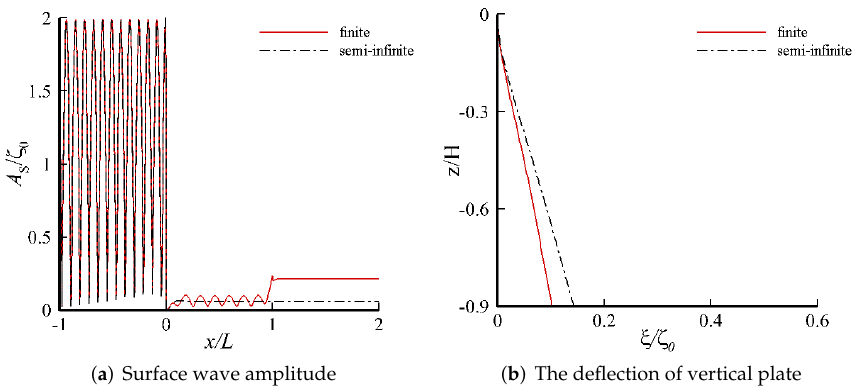
Figure 7. Wave amplitudes A S ( x ) and deflection of vertical plate ξ ( z ) with ω =